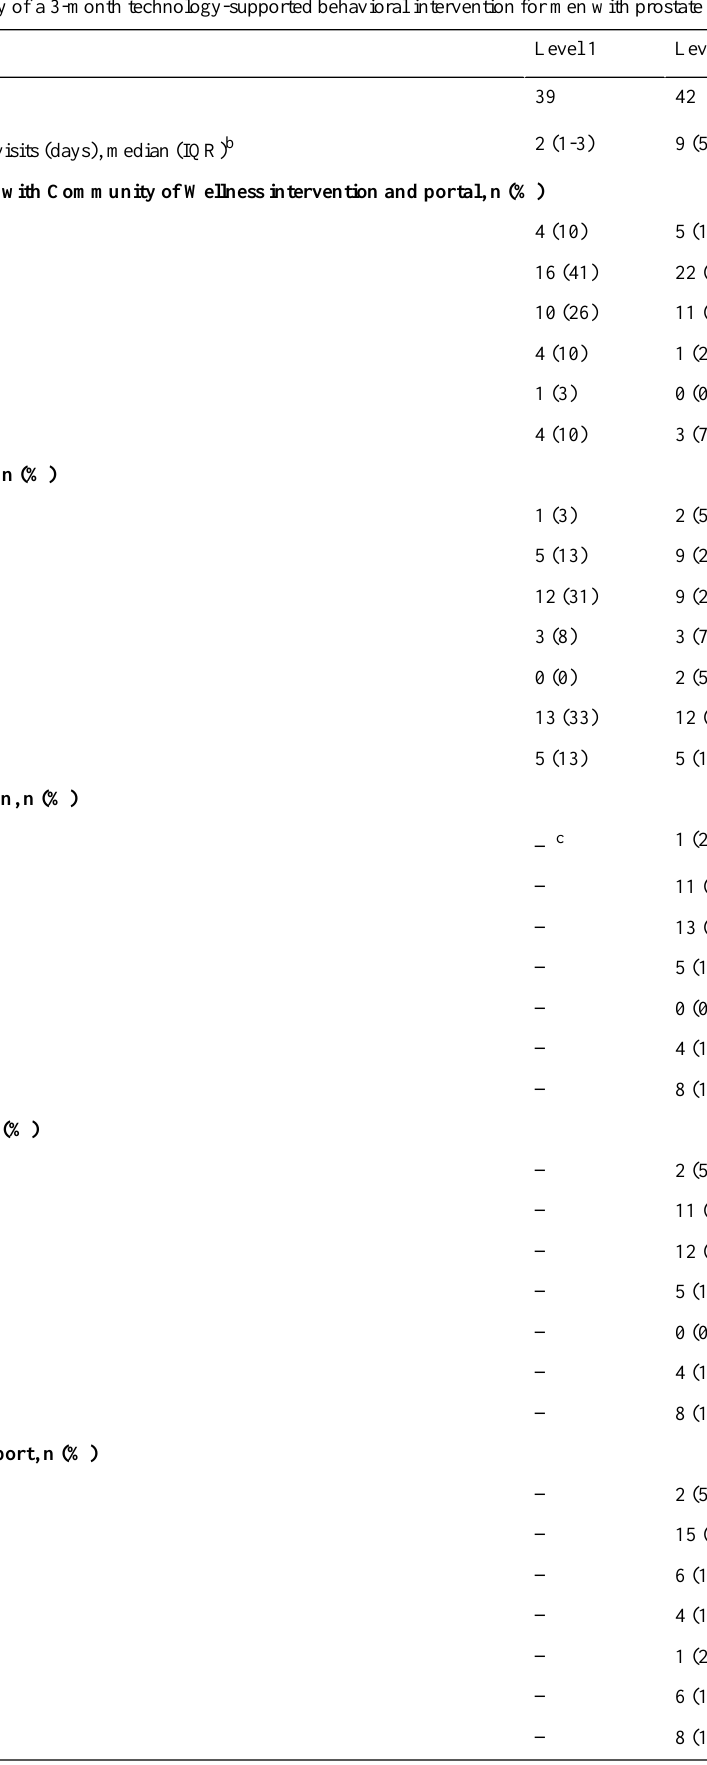
Table 2. Acceptability of a 3-month technology-supported behavioral intervention for men with prostate cancer by level of intervention